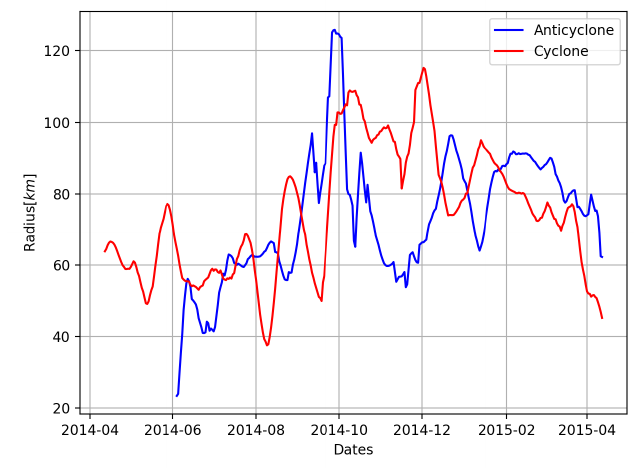
Figure 4. Time series of the Ras al Hadd cyclone and anticyclone radii from April 2014 to